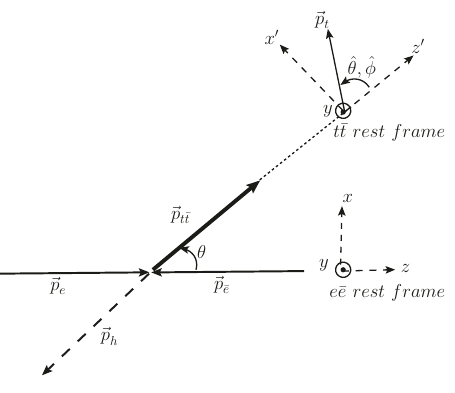
Figure 2 . Kinematics of the e (cid:22) e